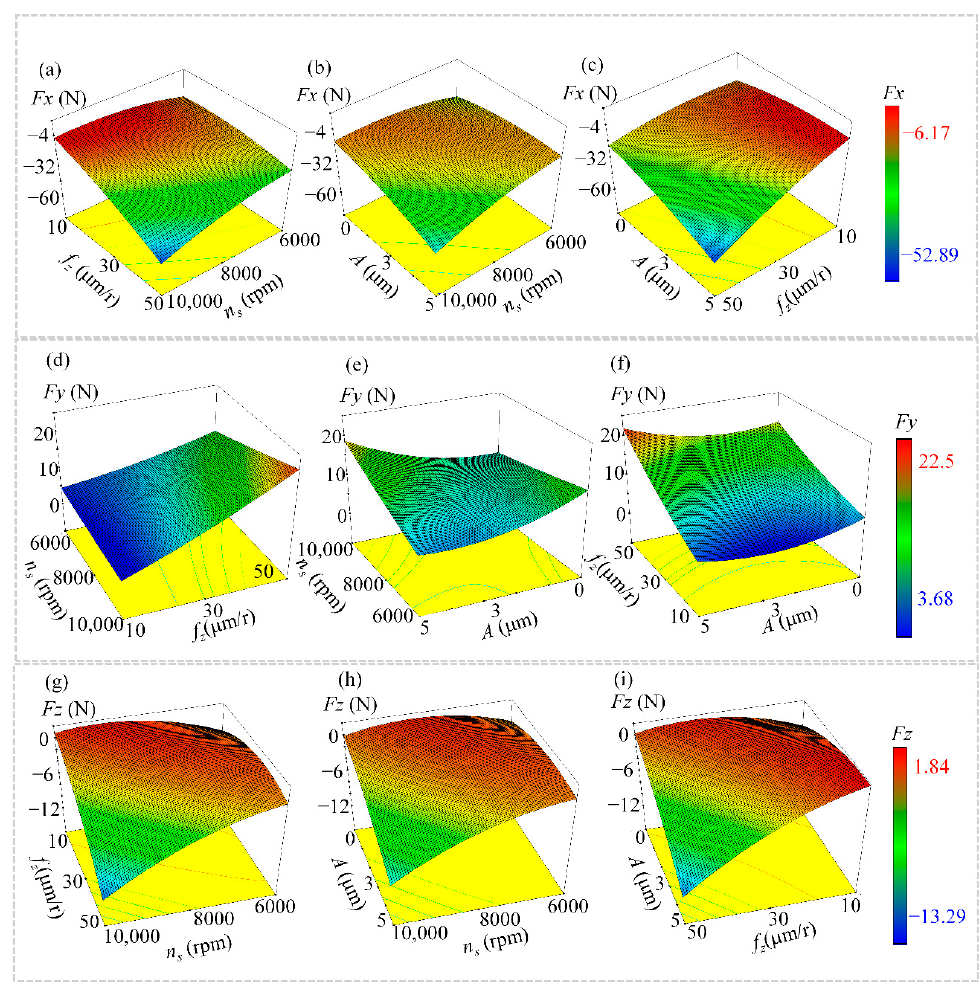
Figure 3. The coupled effects of milling parameters ( n s , f z and A ) on cutting forces Fx , Fy and Fz . ( a ), ( d ), ( g ) Interactive effect of feed per tooth and spindle speed on milling force Fx,Fy,Fz ; ( b ), ( e ), ( h ) Interactive effect of ultrasonic amplitude and spindle speed on milling force Fx,Fy,Fz ; ( c ), ( f ), ( i ) Interactive effects of ultrasonic amplitude and feed per tooth on milling forces Fx,Fy,Fz.